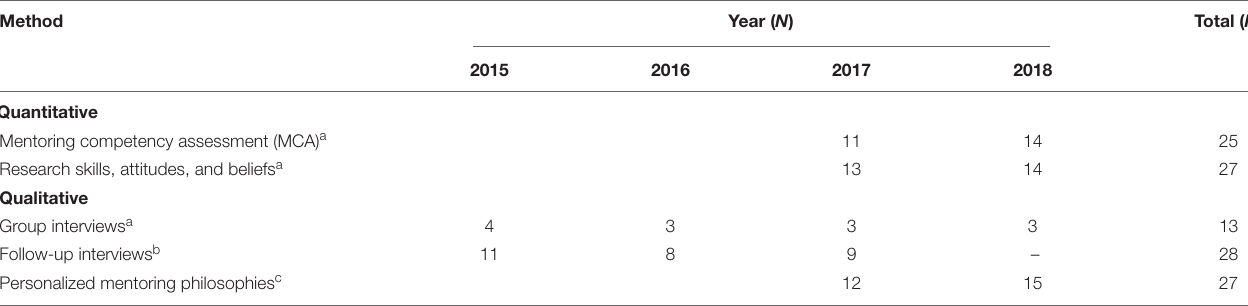
TABLE 2 | Mixed-methods research approach used to study the effects of Project TRUE on mentors’